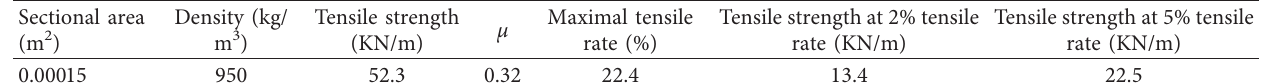
Table 4: Geogrid mechanical performance indicators.